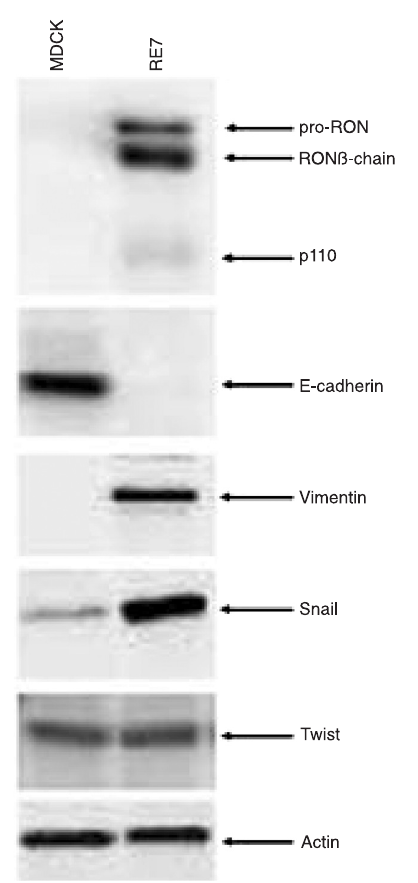
Figure 3. Induction of epithelial-mesenchymal transition and changes of related proteins by RON. Cellular proteins from MDCK and RE7 cells without any stimulation were probed in Western blots with five antibodies specific for RON, E-cadherin, vimentin, Snail, and